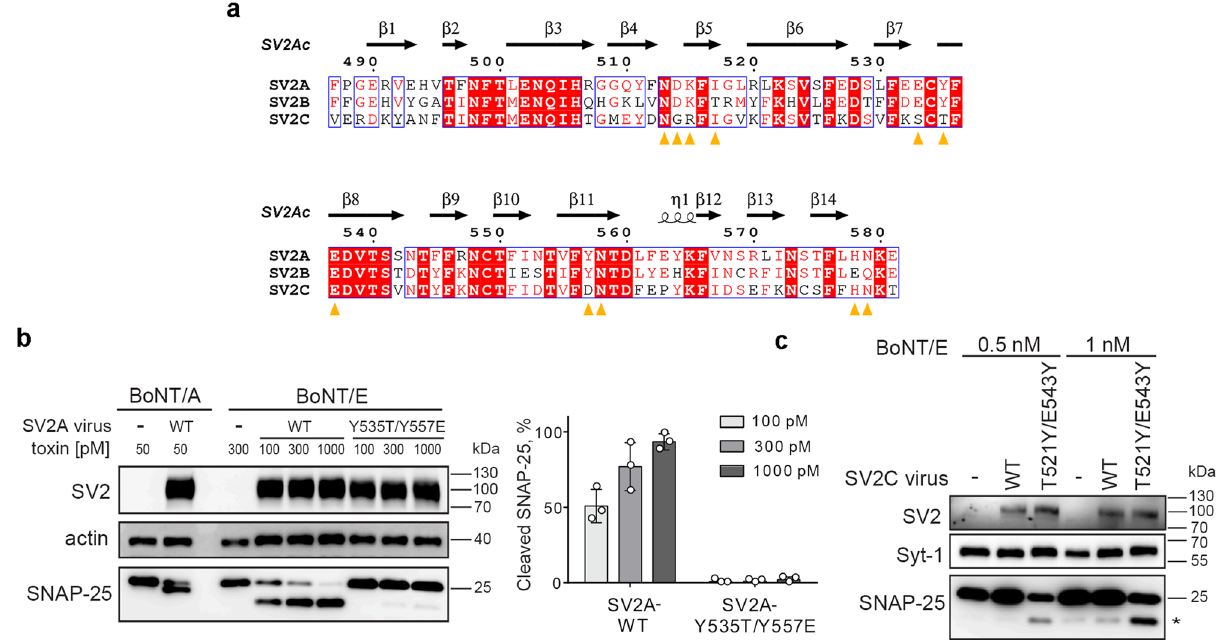
Fig.6|BoNT/EdifferentiatesSV2AandSV2BfromSV2C.a Aminoacidsequence alignment among human SV2A, SV2B and SV2C in the L4 region (prepared using MultAlin 75 andESPript3.0 76 ).Identicalresiduesareindicatedwithwhitelettersona red background, conserved residues are in red letters, and varied residues are in blackletters.TheSV2AresiduesthatarerecognizedbyH C Eareindicatedbyorange triangles. Residue numbers of SV2A and the secondary structures of chimeric SV2Acareshownonthetop. b TheWTSV2AorSV2A Y535T/Y557E mutantwasexpressed in SV2A/B KO mouse cortical neurons via lentiviral transduction. Neurons were exposed to the indicated toxins (14h in medium). Cell lysates were harvested and